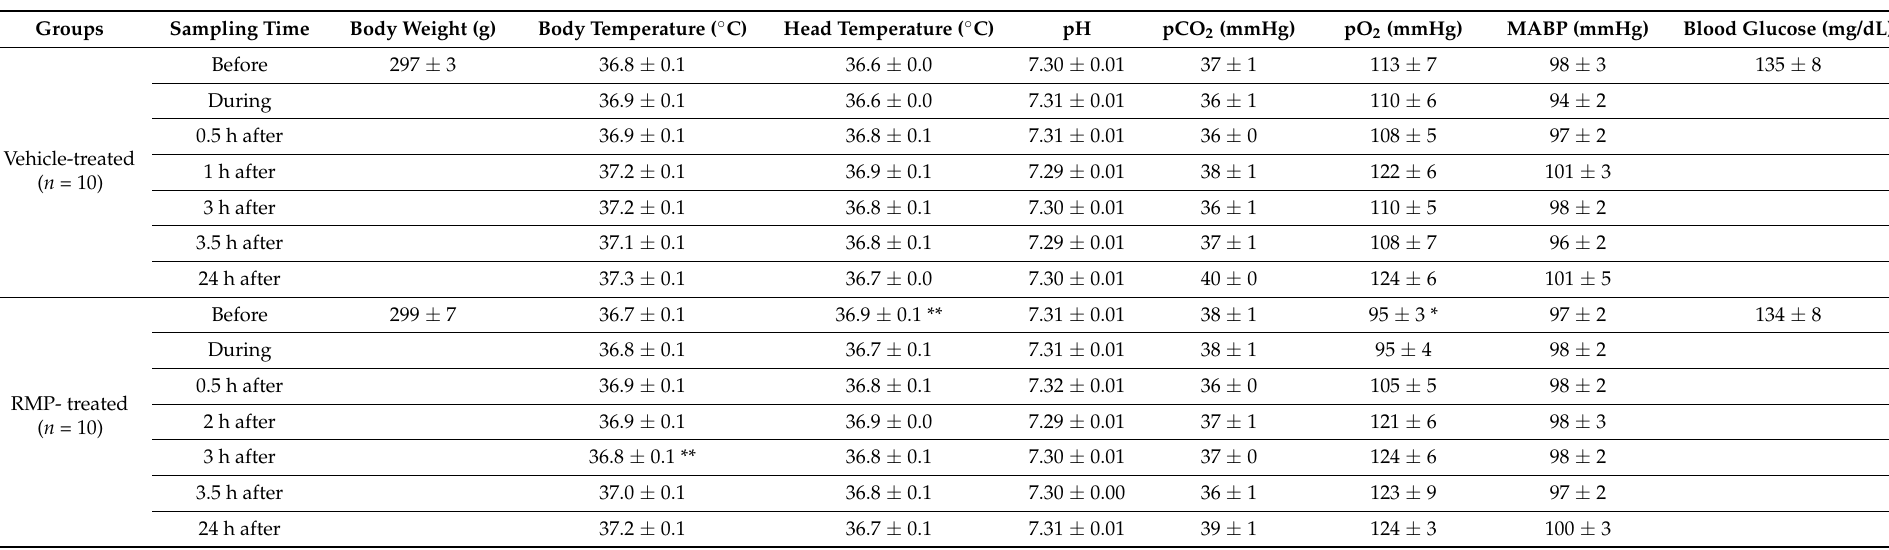
Table 1. Physiological parameters before, during, and after collagenase injection and during vehicle/RMP treatment in male rats employed in the efficacy experiment.